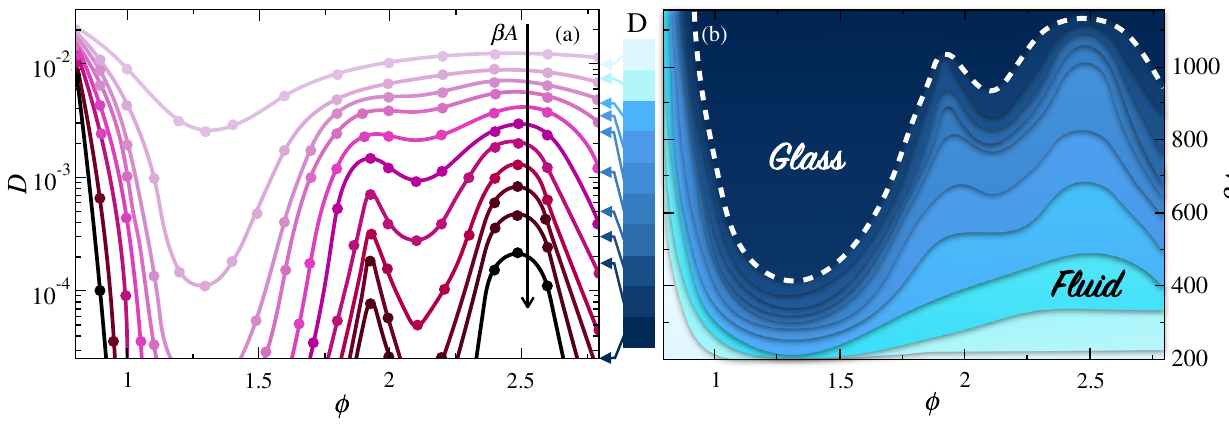
FIG. 4. 2D Hertzian phase diagram. (a) Diffusion coefficient D as a function of the area fraction ϕ for different values of the 2D Hertzian strength A . From top to bottom, A takes the following values: 226, 340, 409, 453, 566, 680, 793, 906, 974, 1042, 1133 k B T ; symbols are simulation data and lines serve as guides to the eye. The lowest reported value of D is taken as the nonergodicity limit; (b) Phase diagram showing β A as a function of ϕ , extracted by taking the iso- D lines from (a). The dashed line signals the onset of the glass region; state points with the same color coding have the same value of diffusion